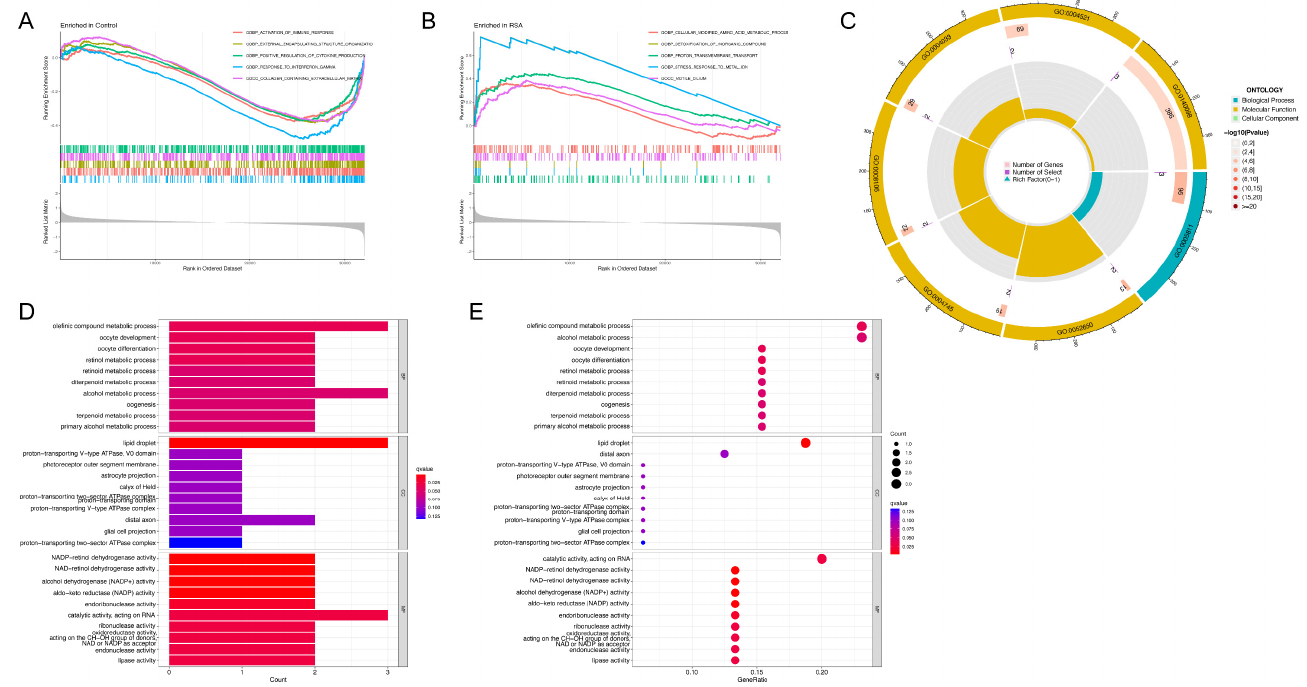
Figure 7. GSEA and functional enrichment of DEGs. ( A ) Enrichment analysis in the control group via gene set enrichment analysis. ( B ) Enrichment analysis in the RSA group via gene set enrichment analysis. ( C ) GO functional enrichment analysis based on DEGs among three subtypes in the circle chart. ( D ) GO functional enrichment analysis based on DEGs among three subtypes in the barplot chart. ( E ) GO functional enrichment analysis based on DEGs among three subtypes in the bubble chart. Table 1. The enriched GO terms of differentially expressed genes.